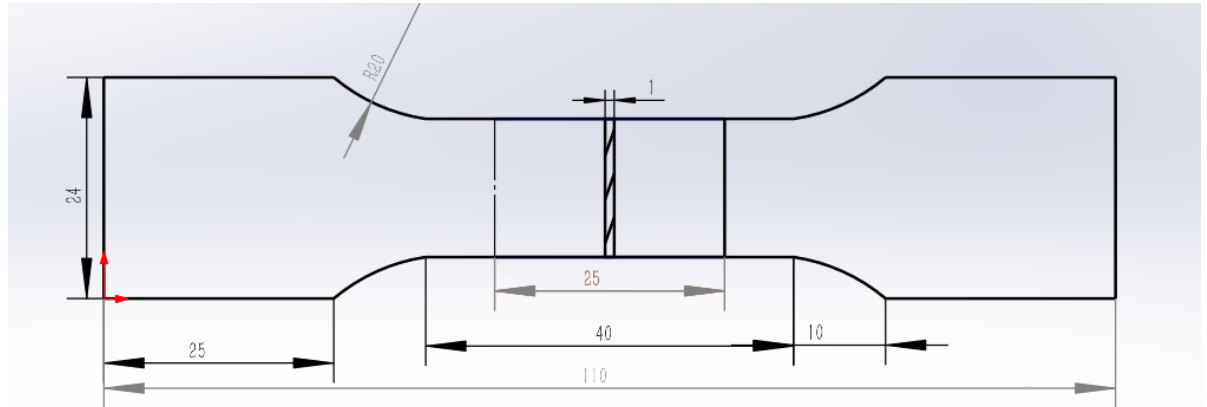
Figure 4. Dimension of tension specimen (mm).